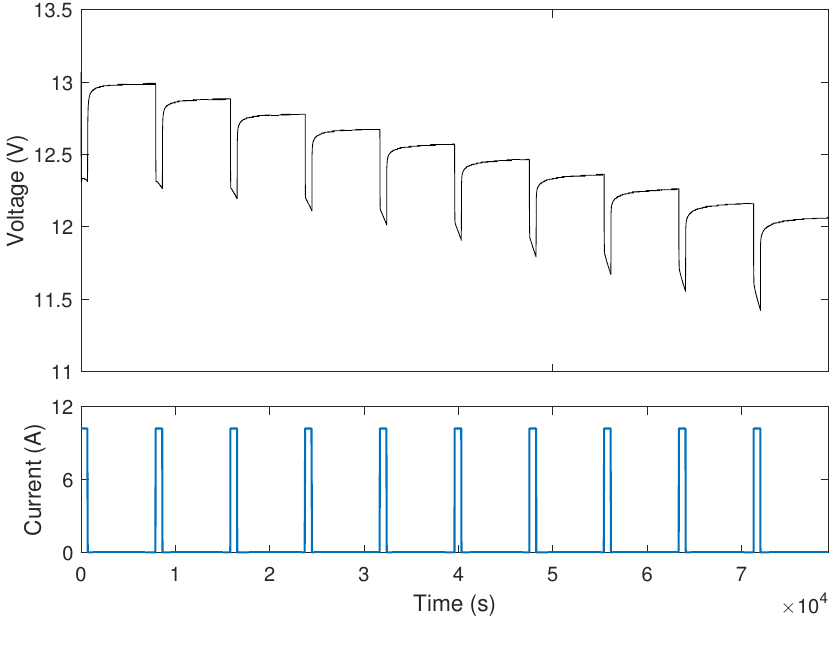
Figure 2. Battery discharge response in test 2 ( I = I m = 10.2 A).